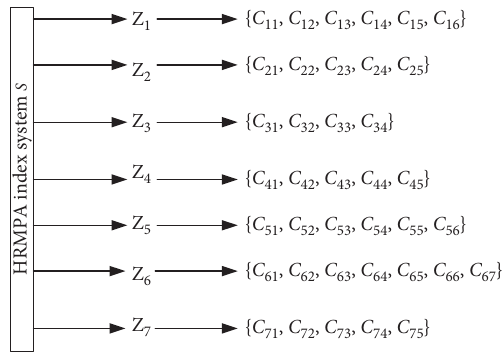
Figure 2: Corporate HRMPA index